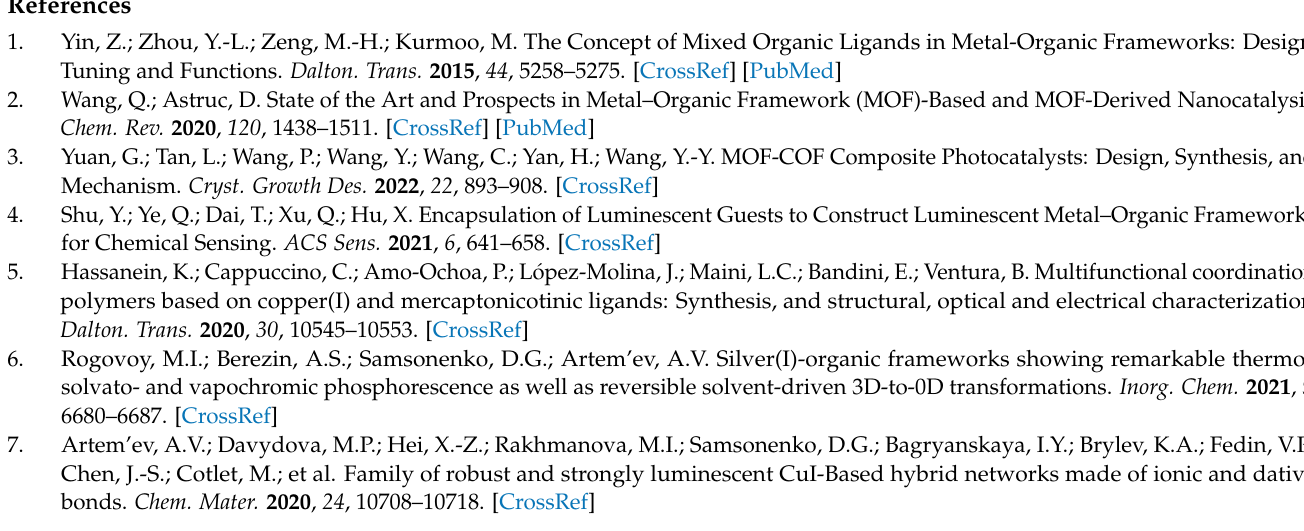
Table S2: Hydrogen-bonding parameters in 2 ; Table S3: Selected bond lengths (Å) and angles (o) for 1 ; Table S4: Selected bond lengths (Å) and angles (o) for 2 . CCDC 2164393 ( 1 ) and